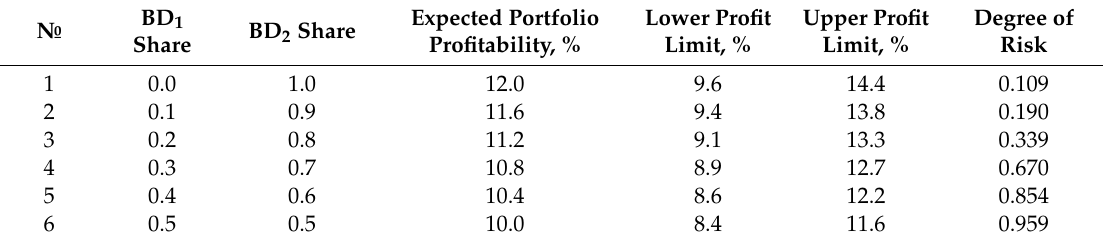
Table 1. The determination of the risk of a two-segment portfolio with the marginal rate r * = 11% per